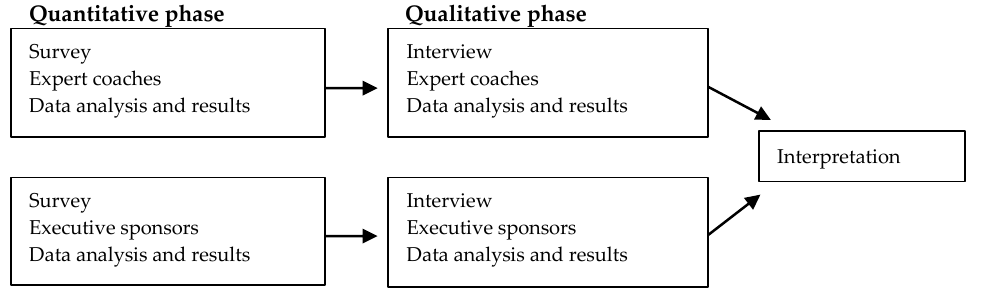
Figure 1. Sequential exploratory mixed-methods study design.